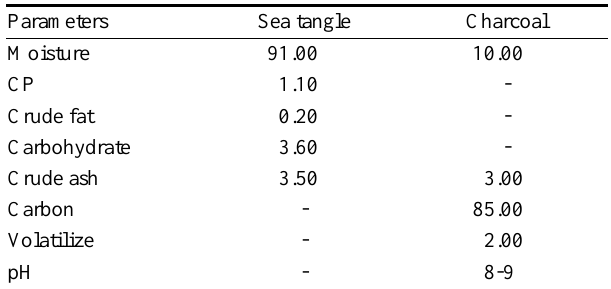
Table 1. Chemical composition of sea tangle ( Laminaria